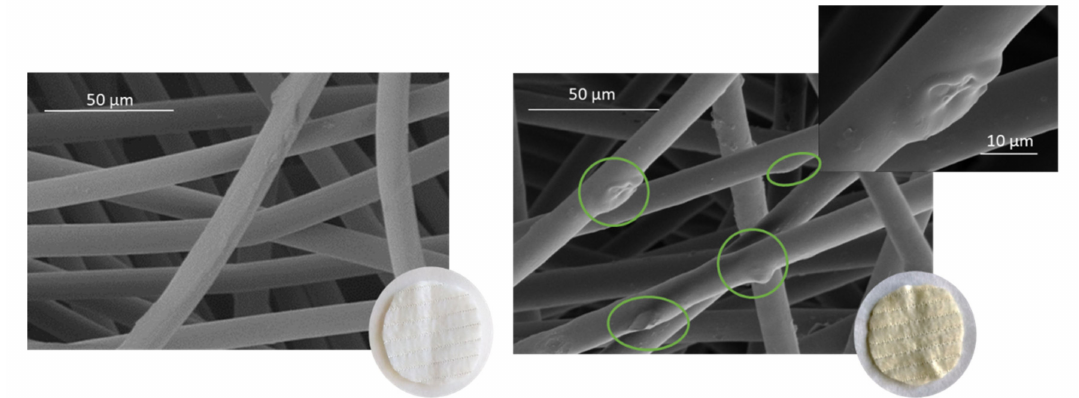
Figure 8. SEM images of the wound dressings before and after impregnation: PD ( A ) and NaCMC ( B